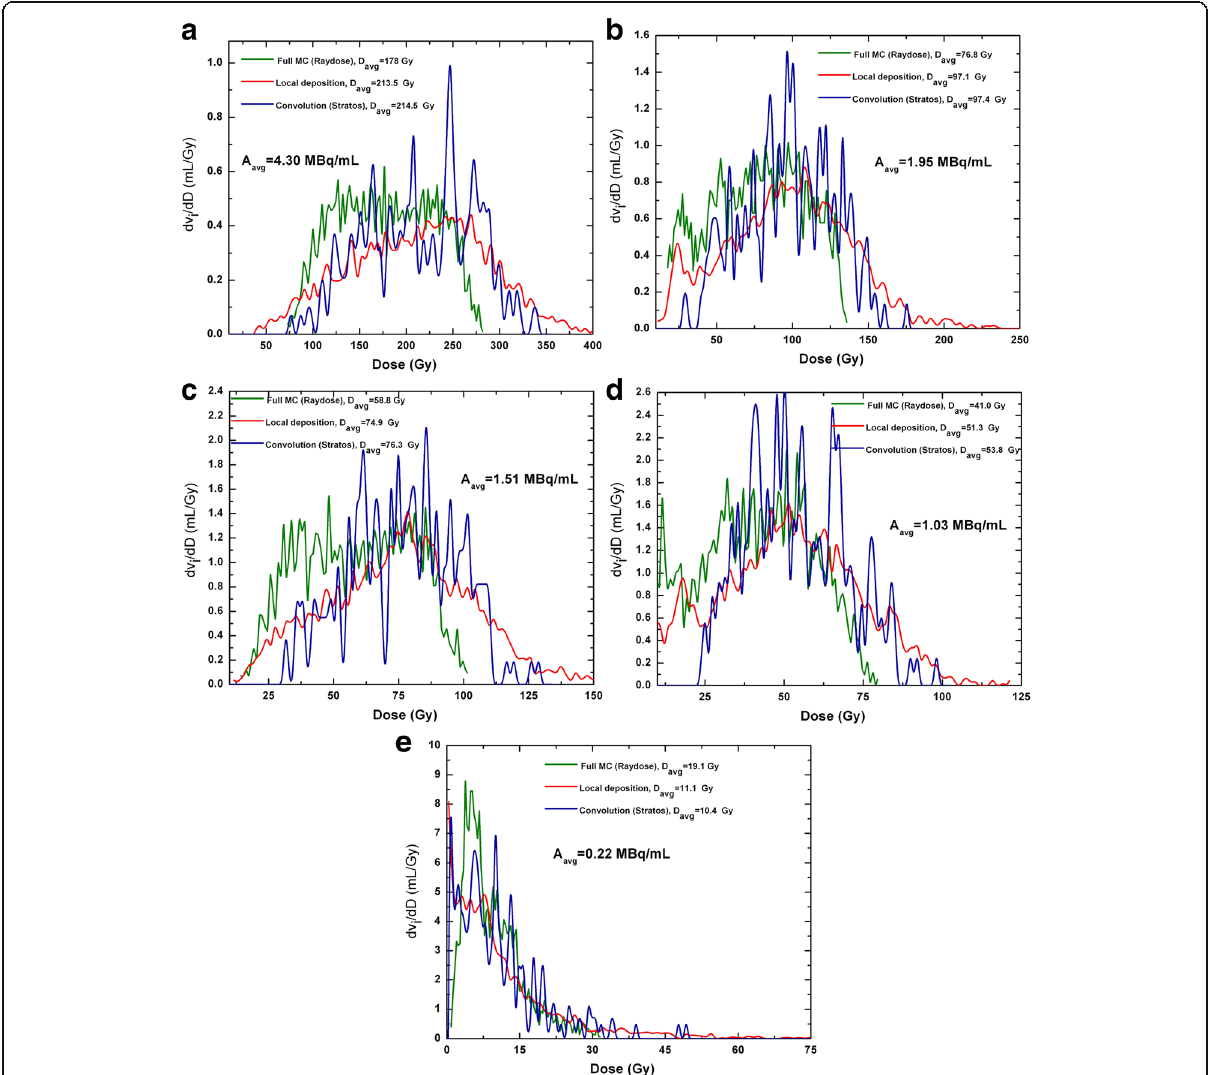
Fig. 6 a – e Comparison of differential DVHs obtained in the cylindrical insert using the three voxel-based dose algorithms. (I) Full Monte Carlo calculations with Raydose, (II) LD algorithm, and (III) convolution approach using Philips Stratos. Results are presented in terms of dv i /dD, i.e., absolute volume element (dv i ) receiving dose in the corresponding dose bin (dD). The integral under each differential DVH yields the insert volume (nominal volume 19.13 mL). VOI contouring performed using methods I and II provided a volume of 19.60 mL (+2.45%), while insert contouring performed with Philips Stratos resulted in a volume of 19.21 mL (+0.42%). The quantity A avg represents the average insert activity concentration assessed from image-based evaluations. Real activity concentrations, measured using the available dose calibrator, are reported in Table